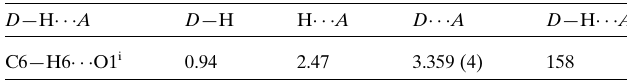
Table 2 Experimental